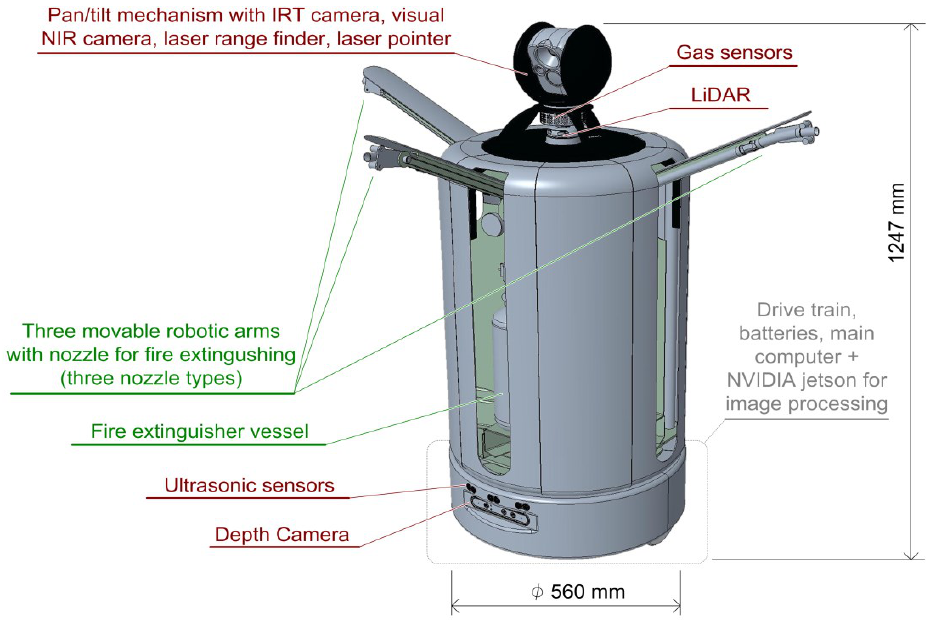
Figure 1. Model of a final version of FireBot.